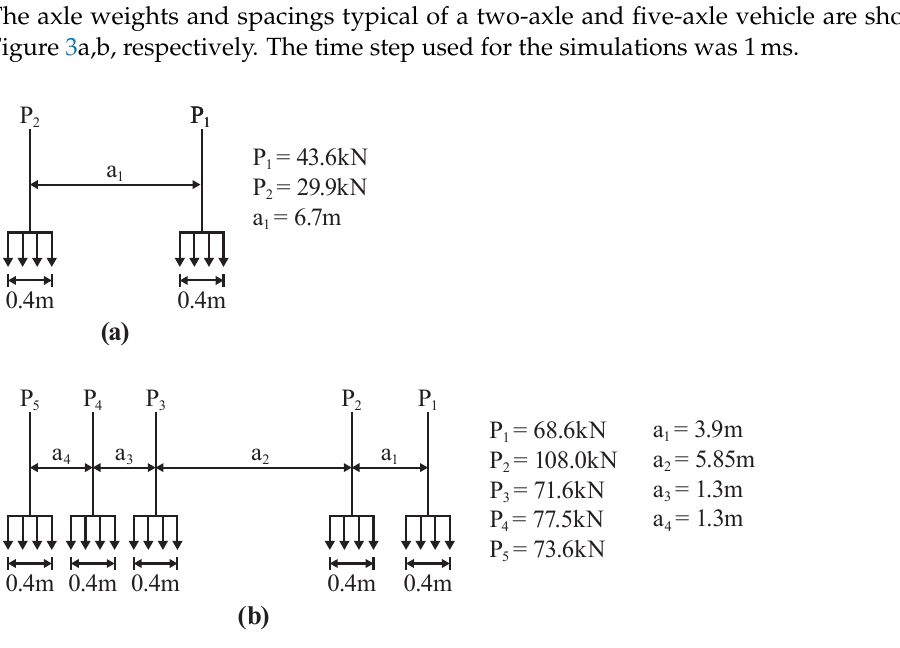
Figure 3. Sketch showing details of the vehicle loads used in the simulations for ( a ) two-axle vehicle and ( b ) five-axle